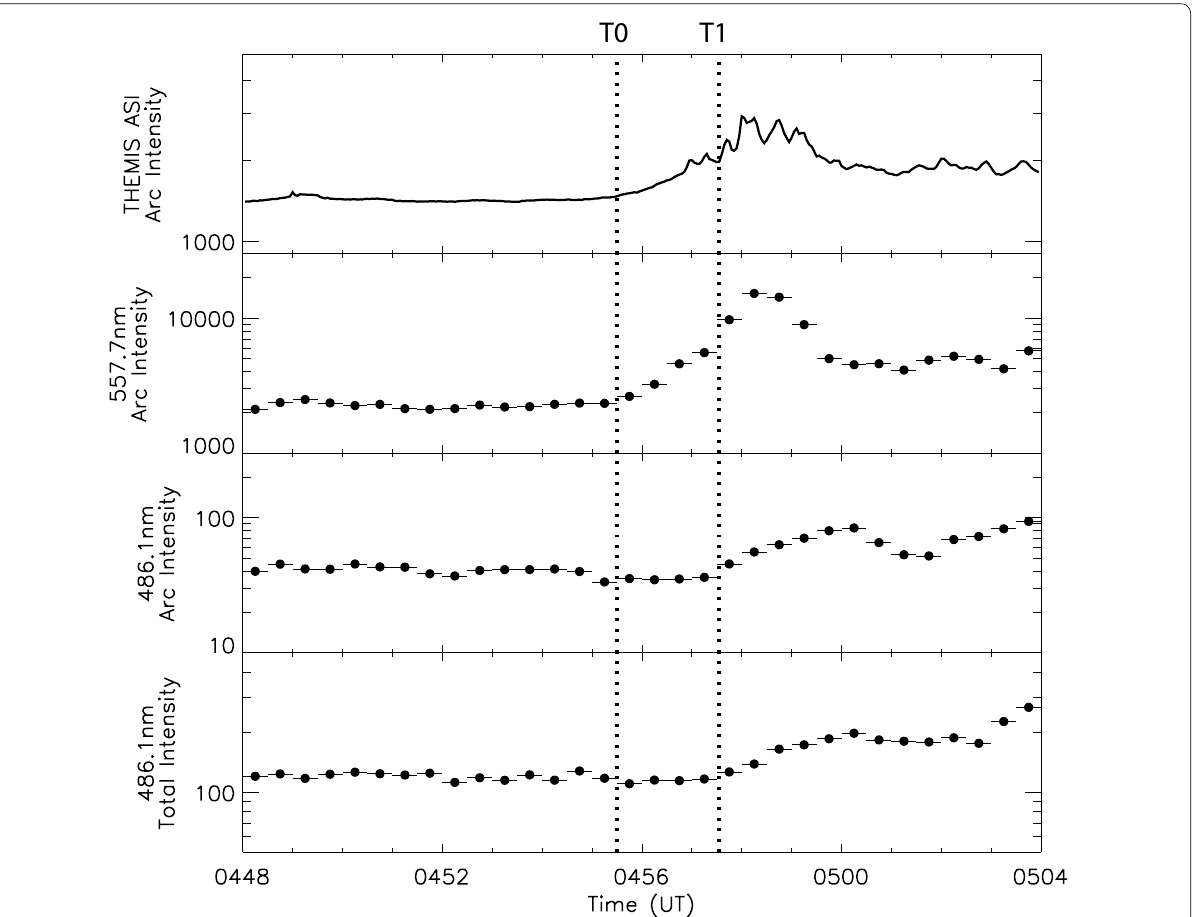
Fig. 3 Comparison of electron aurora and proton aurora. Top panel reproduces the THEMIS ASI counts averaged over the arc band as shown in Fig. 2a. The 2nd panel and 3rd panel shows the green-line electron aurora and 486.1 nm proton aurora intensities, sampled and averaged at the same arc band. The scan time (30 s) of each MSP data point is marked by a horizontal bar. The bottom panel shows the proton auroral intensity integrated over the entire MSP latitudes. TSSO epochs T 0 and T 1 are marked by dotted